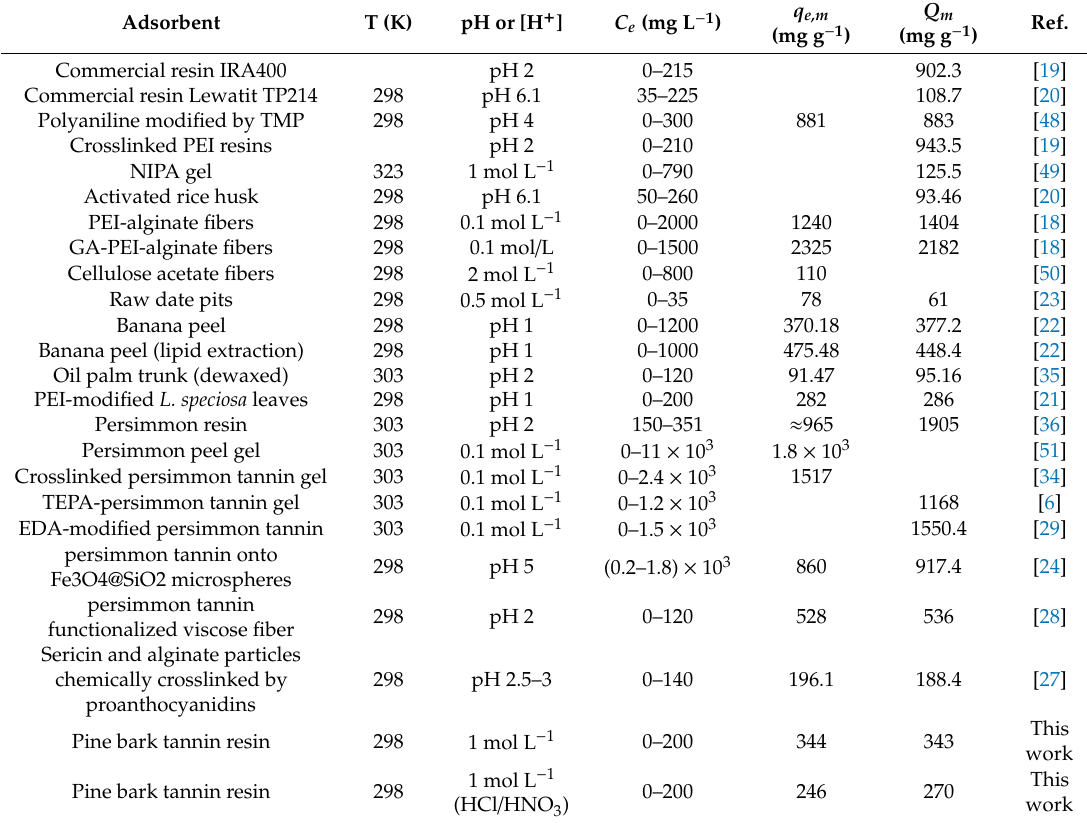
Table 2. Maximum adsorption capacities reported in literature for the adsorption of gold from chloride media by di ff erent adsorbents: maximum adsorbed amounts, obtained experimentally ( q e,m ) and calculated monolayer capacities ( Q m ) by Langmuir